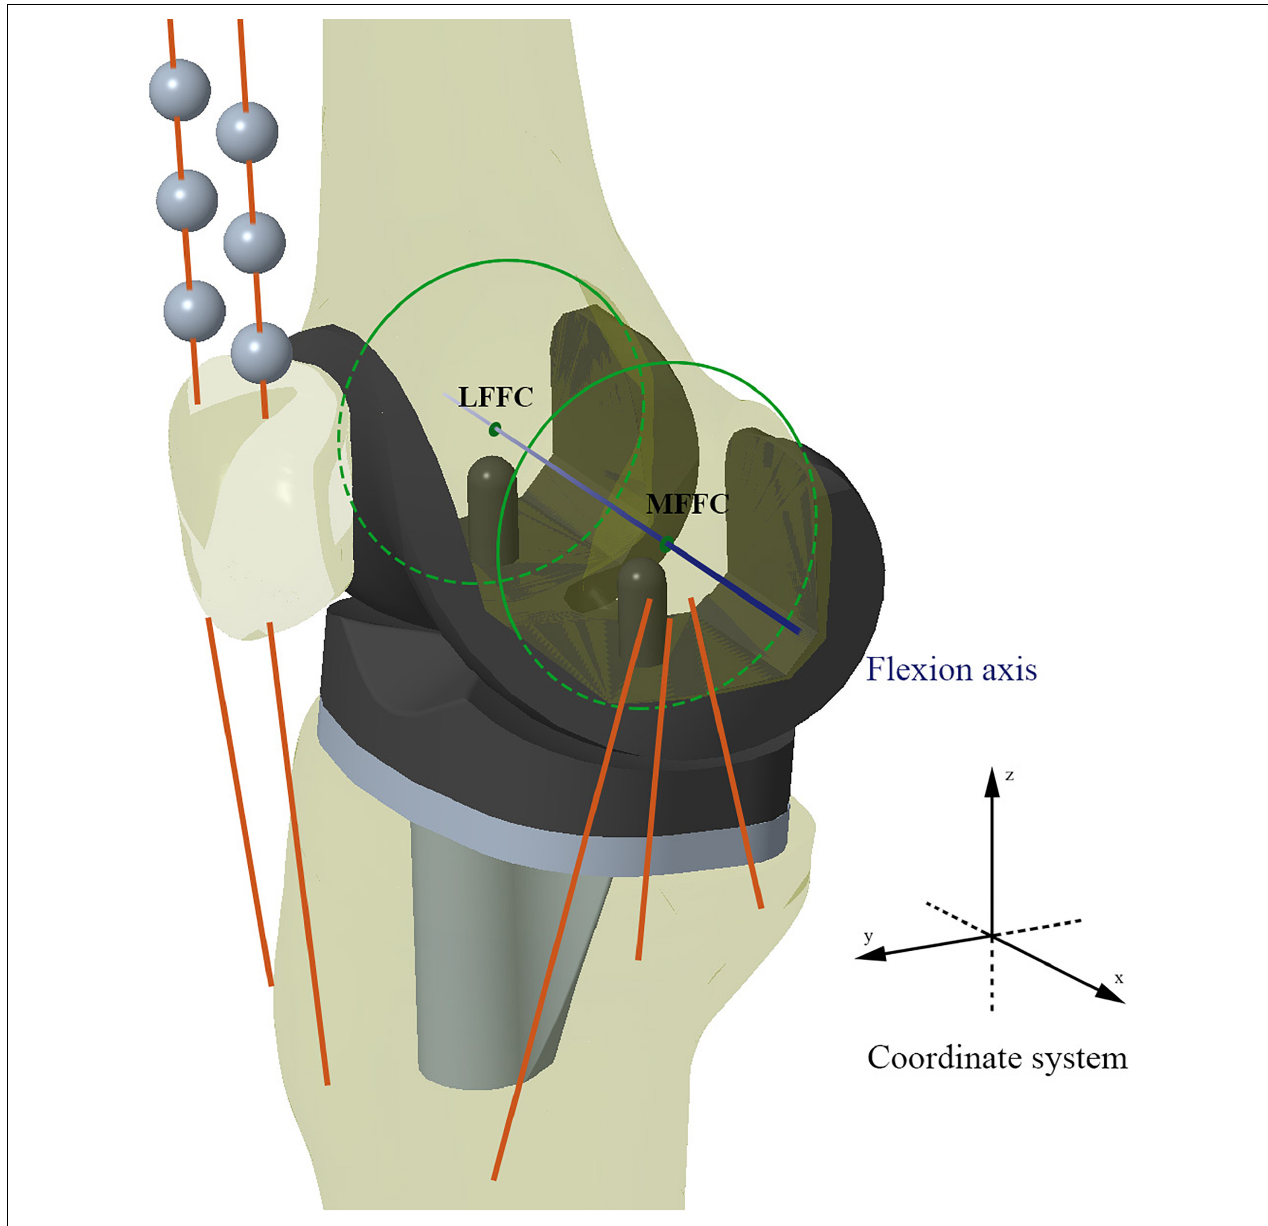
FIGURE 2 | Schematic diagram of the benchmark TKA model (Model 1). MFFC and LFFC are the medial flexion facet center and the lateral flexion facet center of the corresponding femoral component’s posterior condyle, respectively. The knee flexion axis was defined as the connecting line between MFFC and